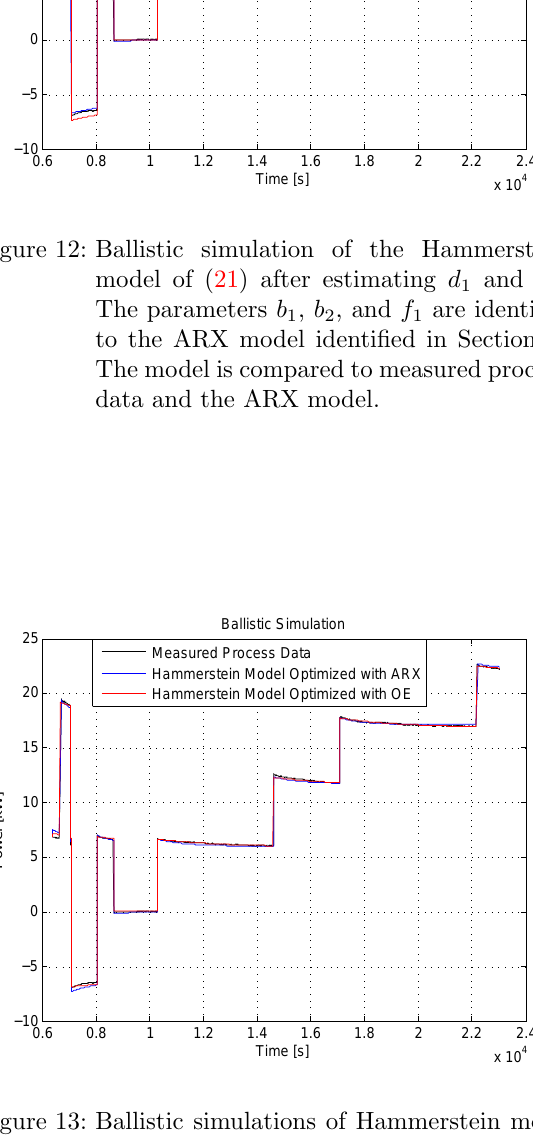
Figure 13: Ballistic simulations of Hammerstein mod- els that are optimized with ARX and OE,